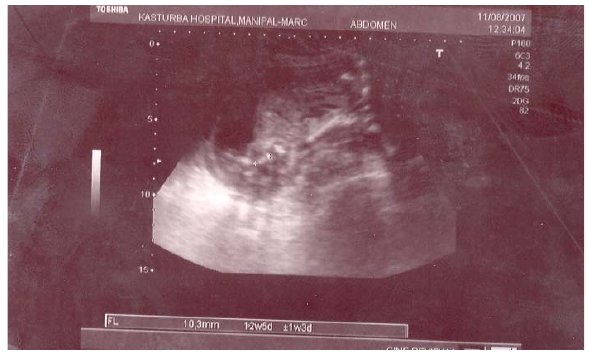
Figure 1. Ultrasound showing severe micromelia with femur length corresponding to 13-weeks at 22-weeks